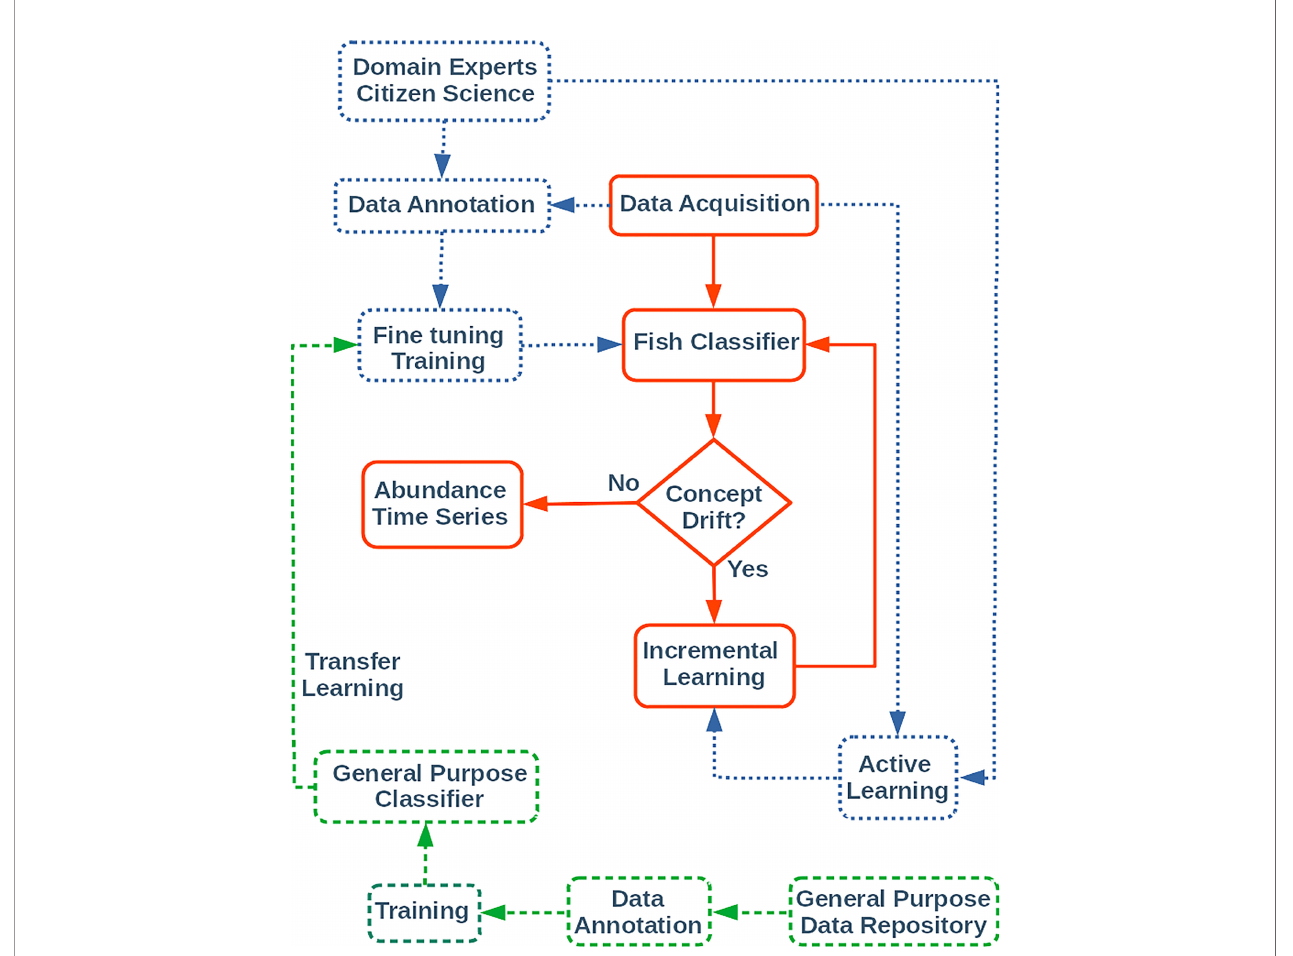
FIGURE 9 | The complete fi sh classi fi cation pipeline for a future automated service at the OBSEA observatory. The continuous red lines and boxes describe the automated service; the dotted blue lines and boxes represent annotation and training activities; the dashed green lines and boxes represent the transfer learning